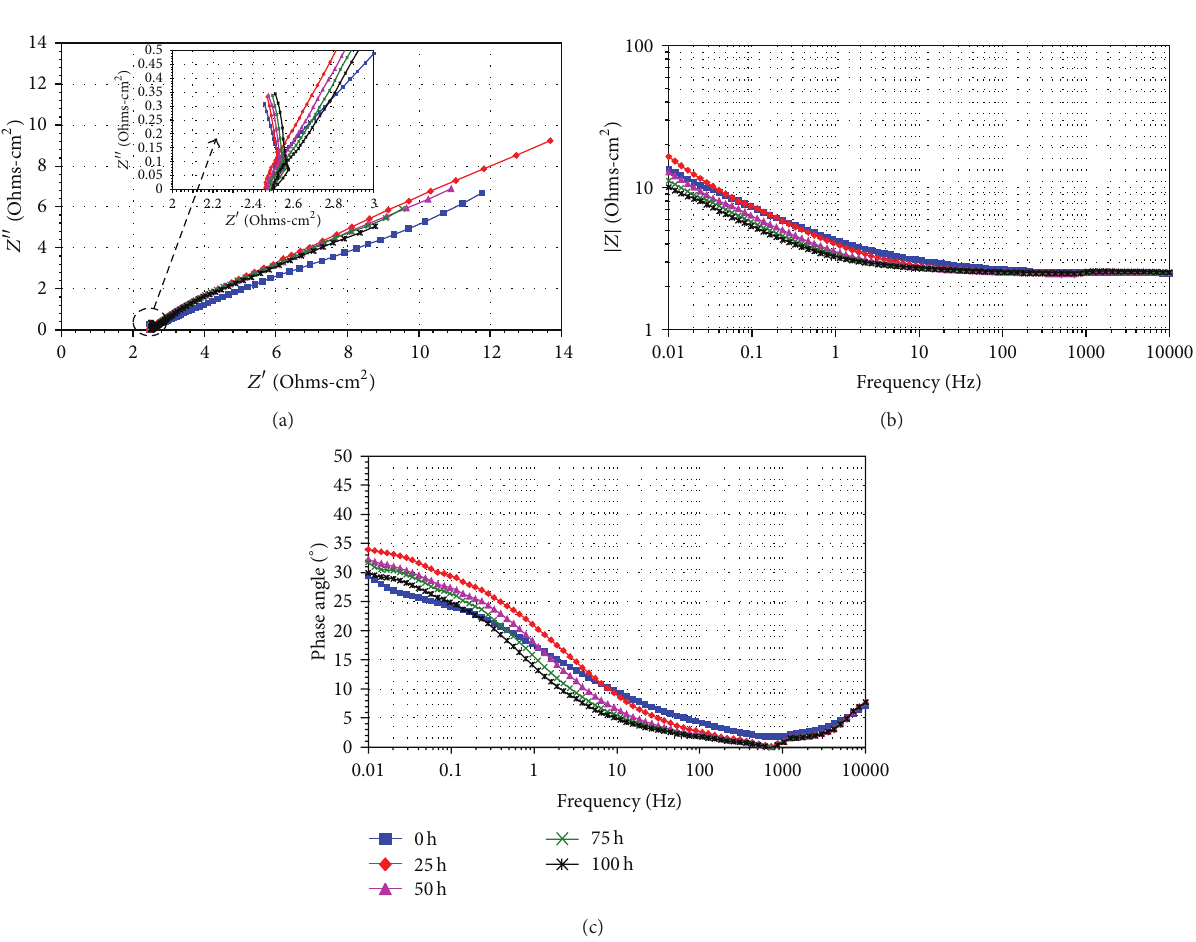
Figure 2: Evolution of the Nyquist and Bode plots of the EIS response of the Cr in NaVO 3 at 700 ∘